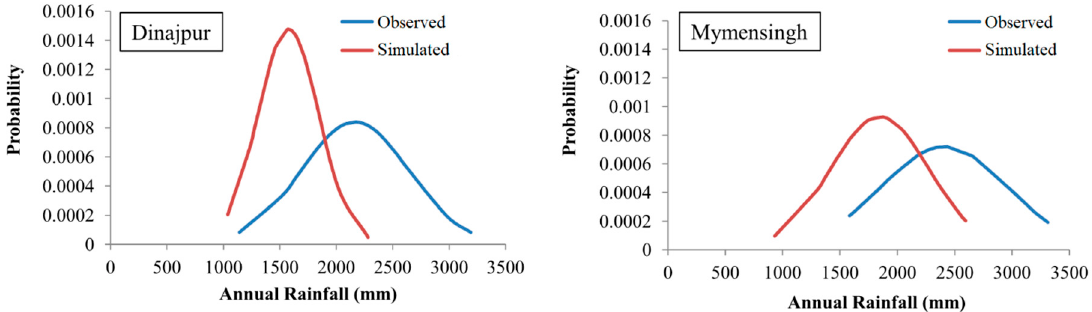
Figure 2. Comparison of probability density functions between observed and simulated annual rainfalls at Dinajpur ( left ) and Mymensingh ( right ) during the base period (1986–2005).